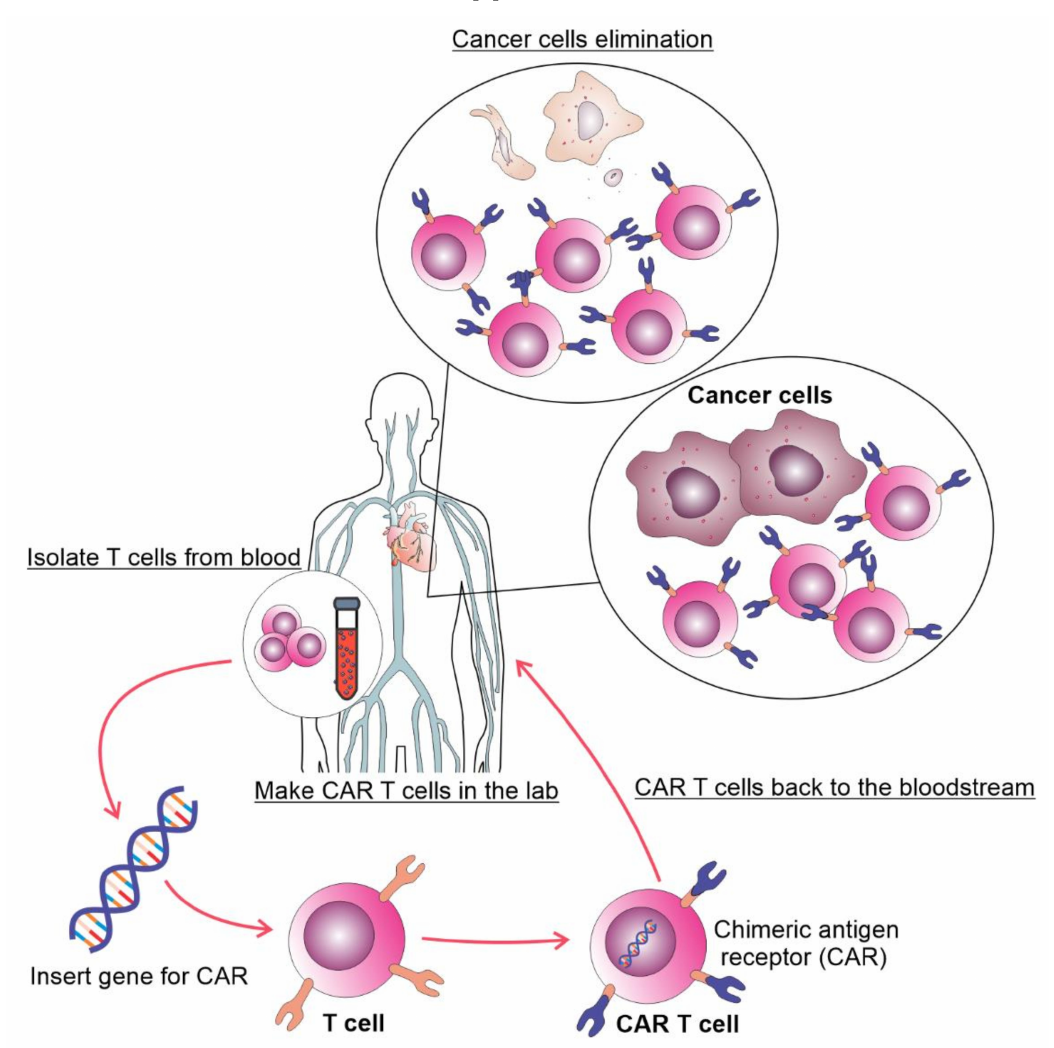
Figure 1. The process of autologous CAR T cell therapy. T cells are collected via apheresis, genetically reengineered in a laboratory by introducing DNA that encodes CAR, multiplied, and then infused into the patient. The CAR T cells may eliminate all of the cancer cells and may remain in the body months after the